Question: What type of chart is this?
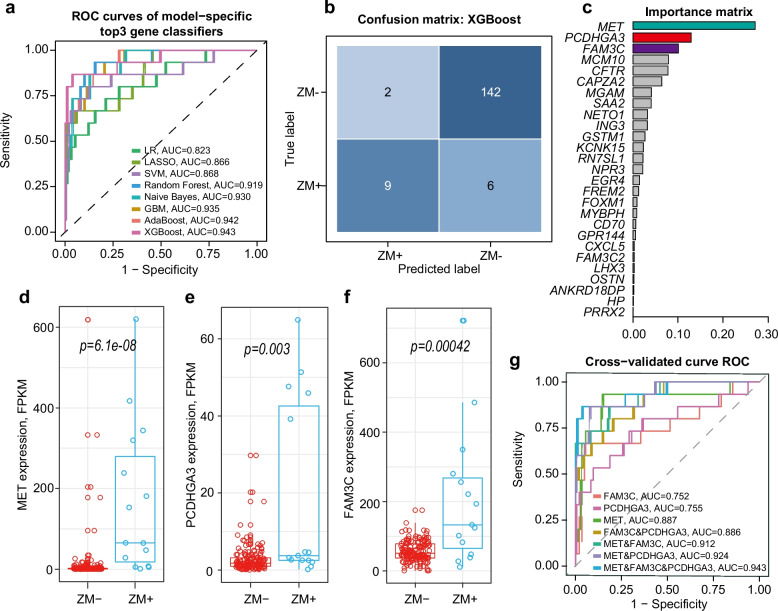
Answer: heatmap